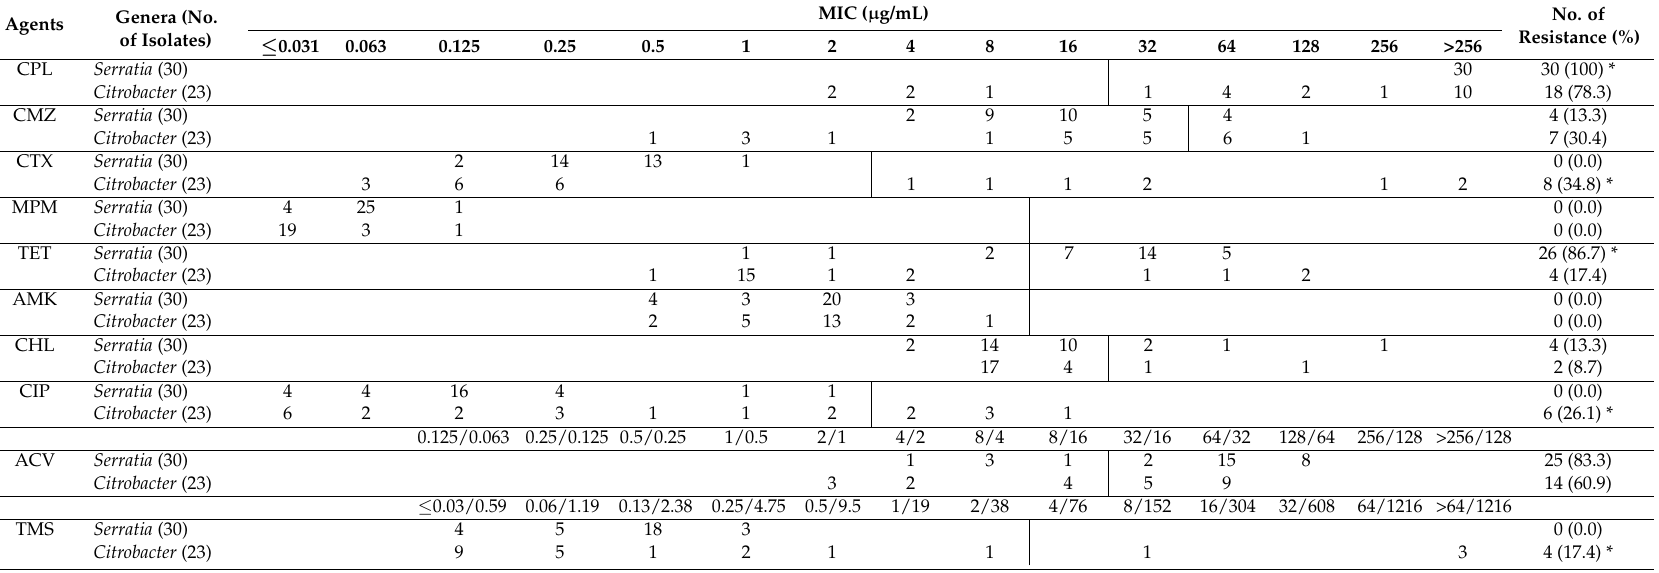
Table 1. Minimum inhibitory concentration (MIC) distribution and resistance rates among Serratia spp. and Citrobacter spp. isolates from dogs and cats. Agents Genera (No. of Isolates)